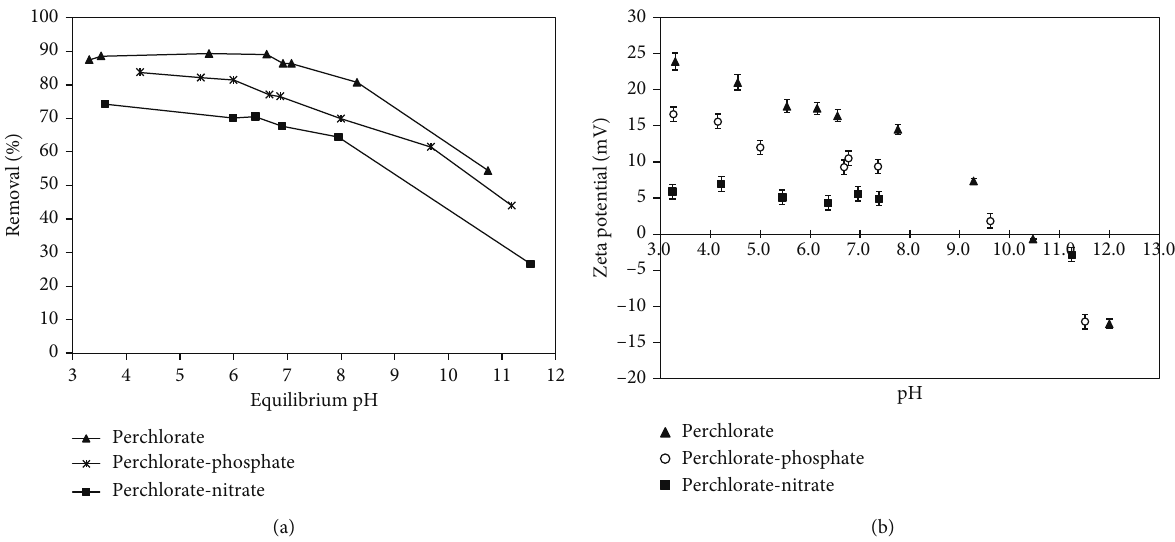
Figure 5: E ff ects of competing anions on MR properties. (a) E ff ect of competing anions on perchlorate removal at di ff erent pH values. (b) for 24 hours (adsorbent dose = 2 : 0 g/L). For both graphs, E ff ect of competing anions on the zeta potential of MR equilibrated with ClO - 4 −  = 30 mg/L, ½ NO −  = 250 mg/L, and ½ PO 43 −  = 50 initial conditions: ½ ClO 4 3